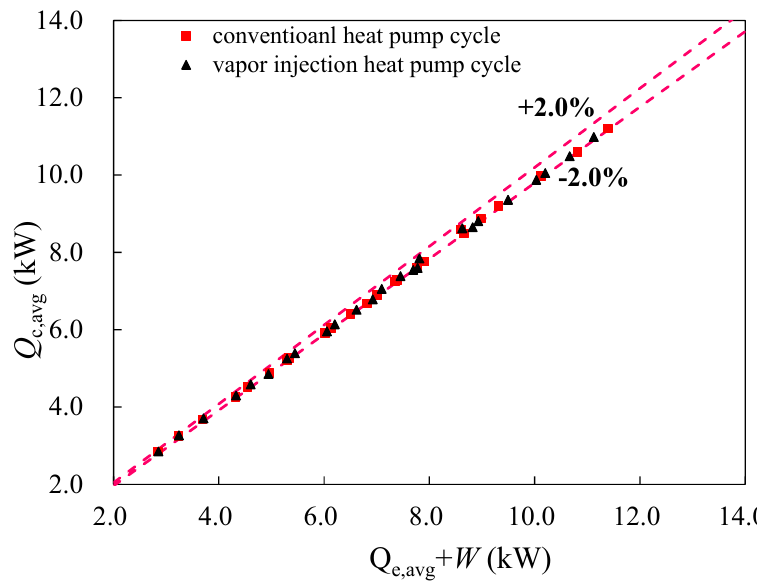
Figure 5. The energy balances of the two heat pump cycles.